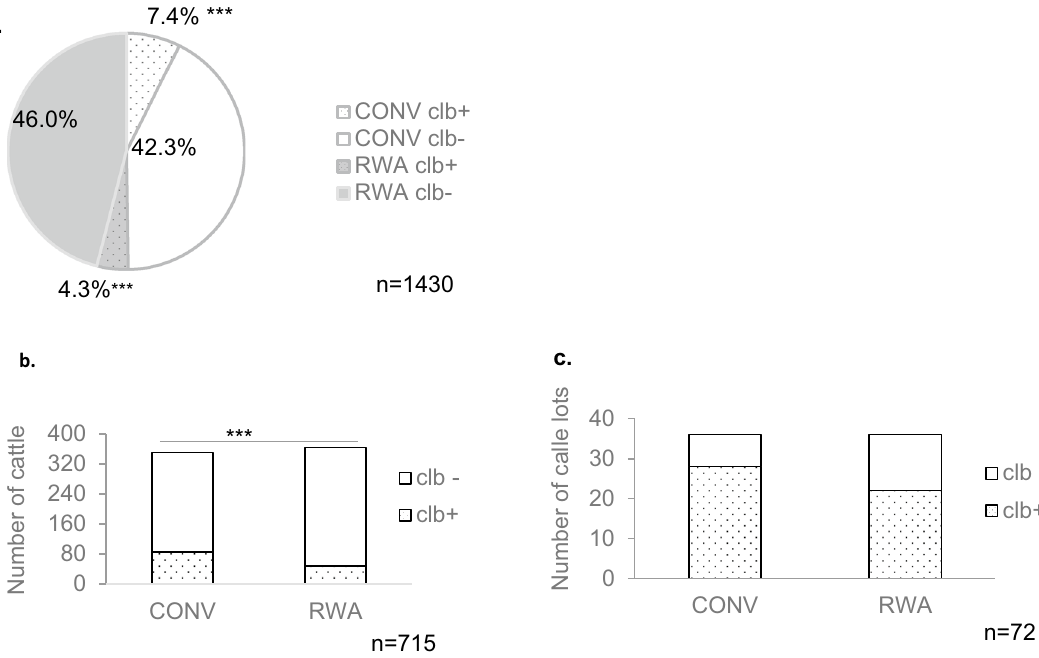
Figure 1. clb + E. coli among cattle-at-harvest. ( a ) Percentage prevalence of clb + E. coli among all generic E. coli isolated from cattle ( b ) Number of animals carrying clb + E. coli . ( c ) Number of cattle lots carrying clb + E. coli. Statistical significance was calculated by Fisher’s exact test. *, significant ( p < 0.05); ***, extremely significant ( p < 0.001). CONV, conventionally raised; RWA, Raised without